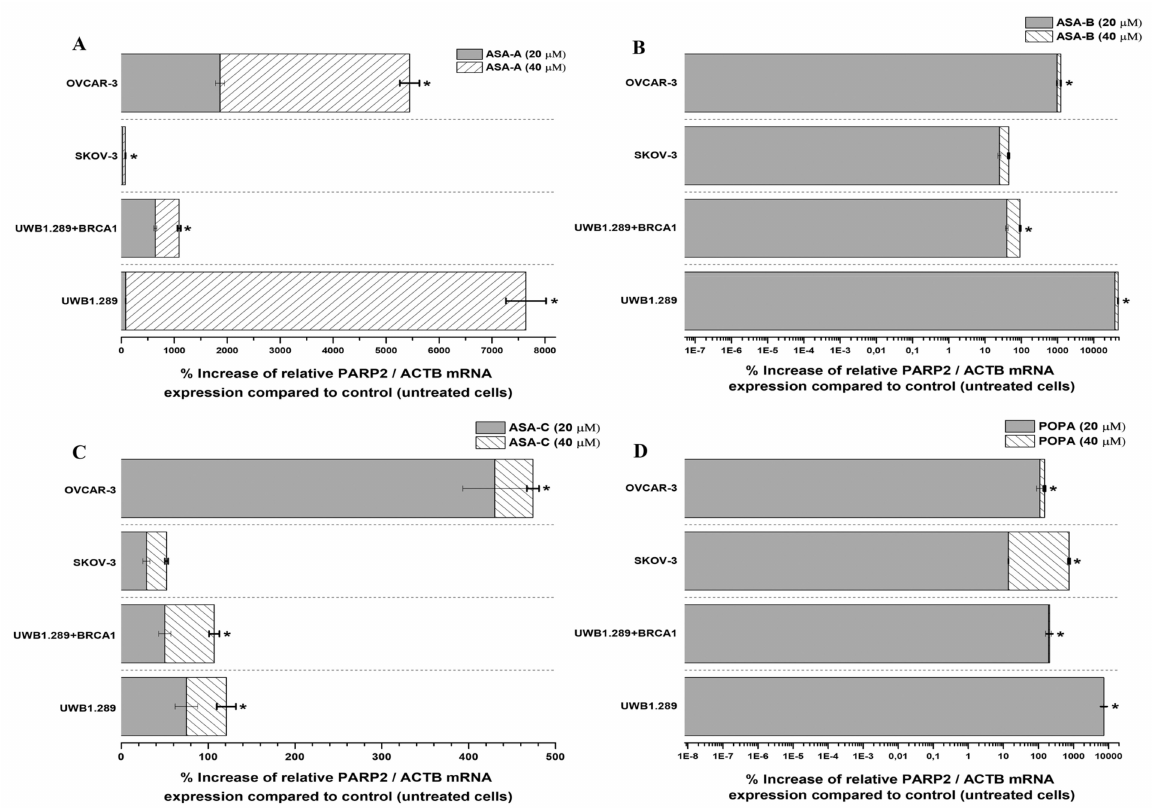
Figure 7. % Increase of the relative PARP2/ACTB mRNA cellular content ( ± Standard Error, SE) as compared to the corresponding control values (untreated cells) induced by the treatment of UWB1.289, UWB1.289 + BRCA1, SKOV-3 and OVCAR-3 human ovarian cancer cells with ASA-A ( A ), ASA-B ( B ), ASA-C ( C ) and POPA ( D ) at 20 and 40 µ M concentrations, respectively, for 72 h. (*) Statistical significance for p < 0.001 (two-tail paired t